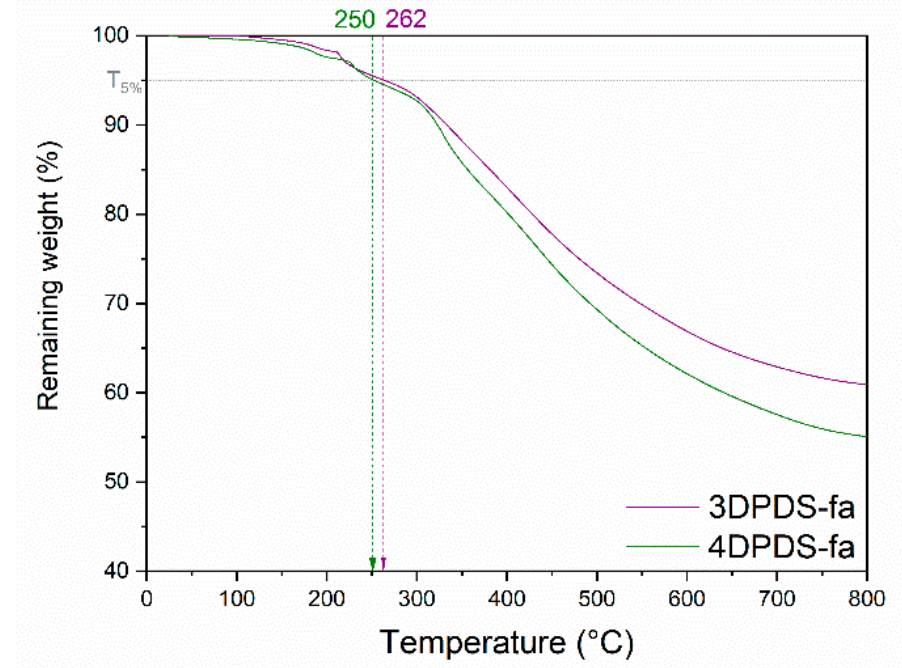
Figure A10. TGA thermograms of 4DPDS-fa, and 3DPDS-fa.